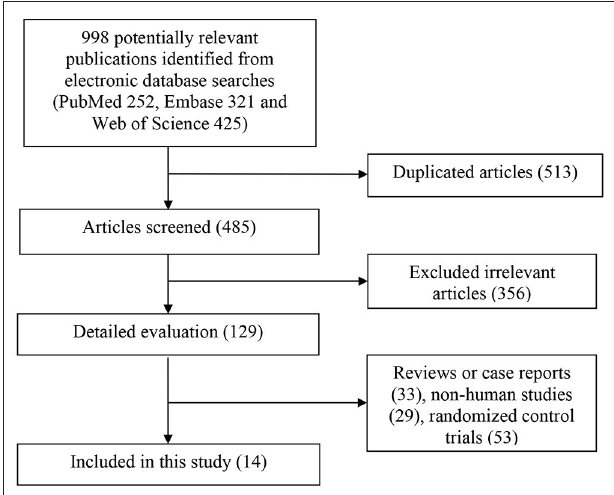
FIGURE 1 | Flow chart for the identification of studies that were included in this